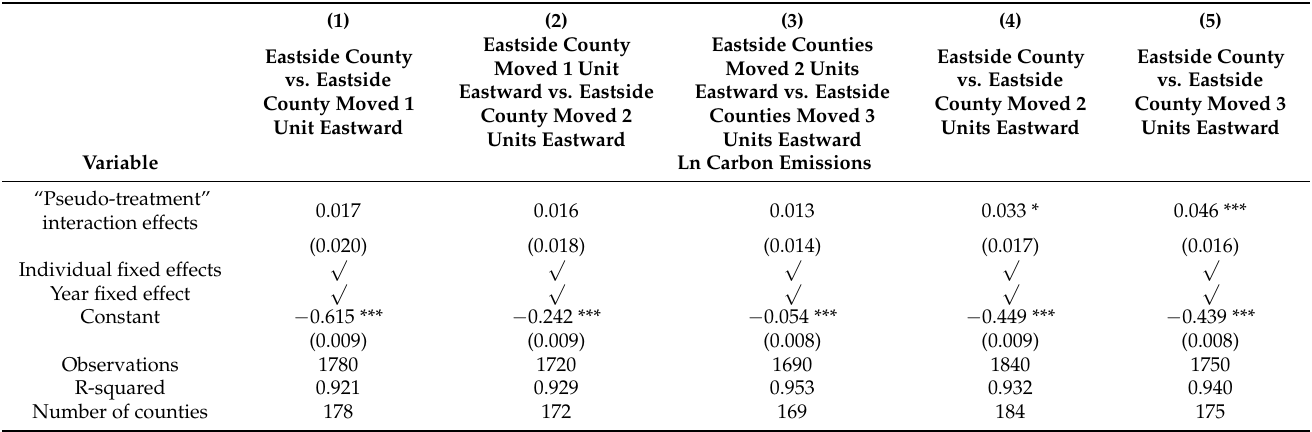
Table 8. Comparison of the impact of the WDS on the total carbon emissions of various counties on the east